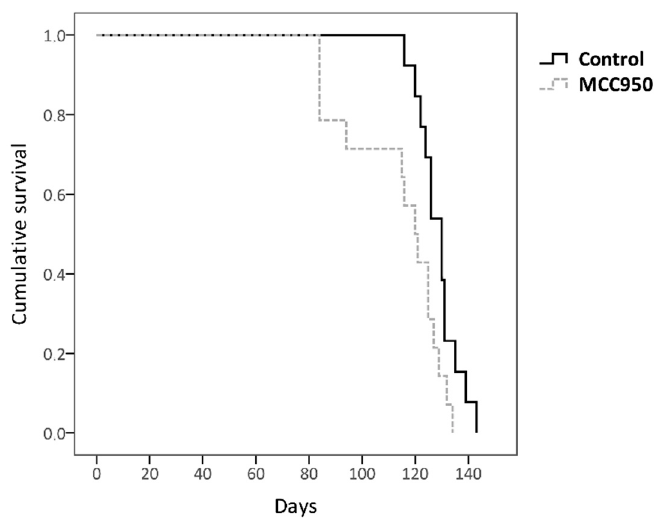
Figure 3. Kaplan–Meier analysis of the effect of MCC950 drug on survival rate. Non-treated transgenic SOD1G93A mice showed a longer lifespan (128.692 days ± 7.54) than